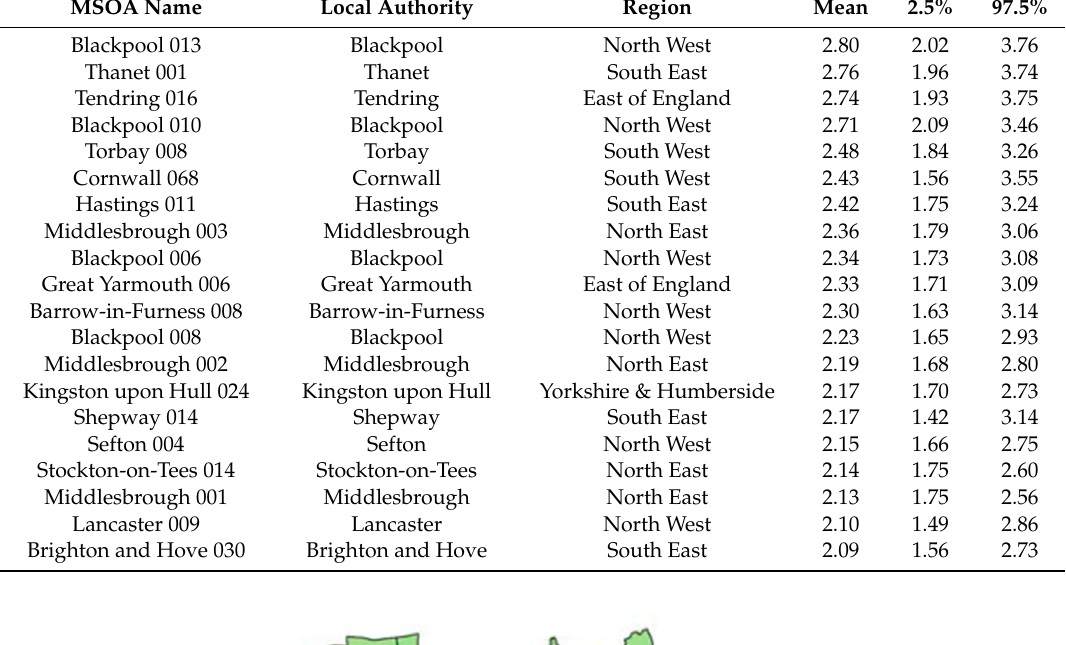
Table 8. MSOAs with Highest Suicide Relative Risk, With Socio-Economic and Locational Details.